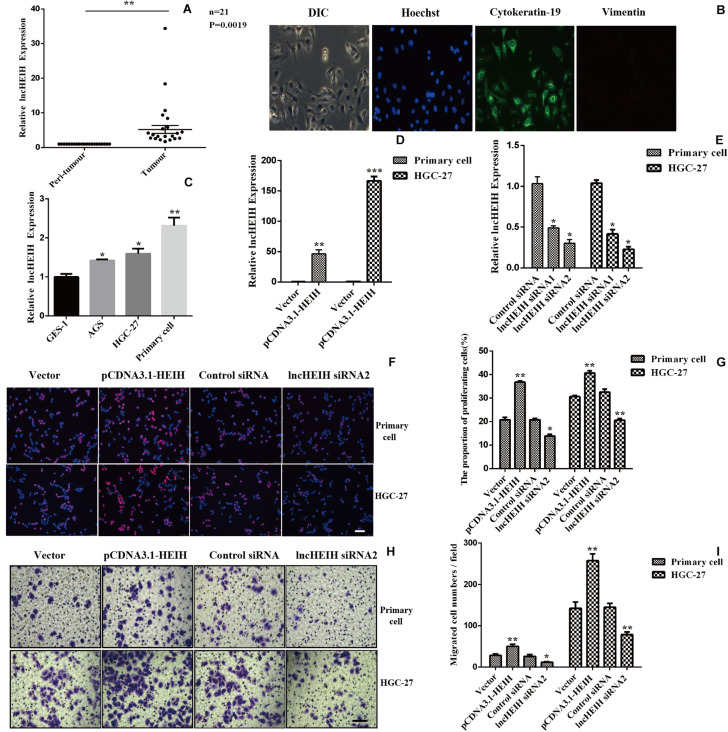
Upregulated lncHEIH in gastric cancer promotes the proliferation and migration of gastric cancer cells. (A) Median lncHEIH expression levels in 21 paired gastric cancer and adjacent normal tissues. (B) Primary gastric cancer cells established from fresh tumor tissues were identified by immunofluorescence. The green fluorescence indicates cytokeratin-19, and the red fluorescence indicates vimentin. (C) Relative lncHEIH levels in the GES-1, AGS, HGC-27 cell lines and primary gastric cancer cells normalized to GAPDH levels. The results are shown as the mean ± standard deviation from three independent experiments. (D,E) LncHEIH levels in gastric cancer cells transfected with lncHEIH or si-lncHEIH for 48 h. (F) Representative images showing the EdU+ proliferating gastric cancer cells transfected with lncHEIH or si-lncHEIH for 48 h. The red color indicates EdU+ nuclei (scale bars = 50 μm). (G) Graphs showing the proportion of EdU+ cells in different groups detected by flow cytometry. (H) Representative images of the Transwell assay showing the migration of gastric cancer cells transfected with lncHEIH or si-lncHEIH (scale bars = 50 μm). (I) Bar graph showing the number of migrated cells. The results shown are the mean ± SD from three independent experiments. *P < 0.05, **P < 0.01, ***P < 0.001.